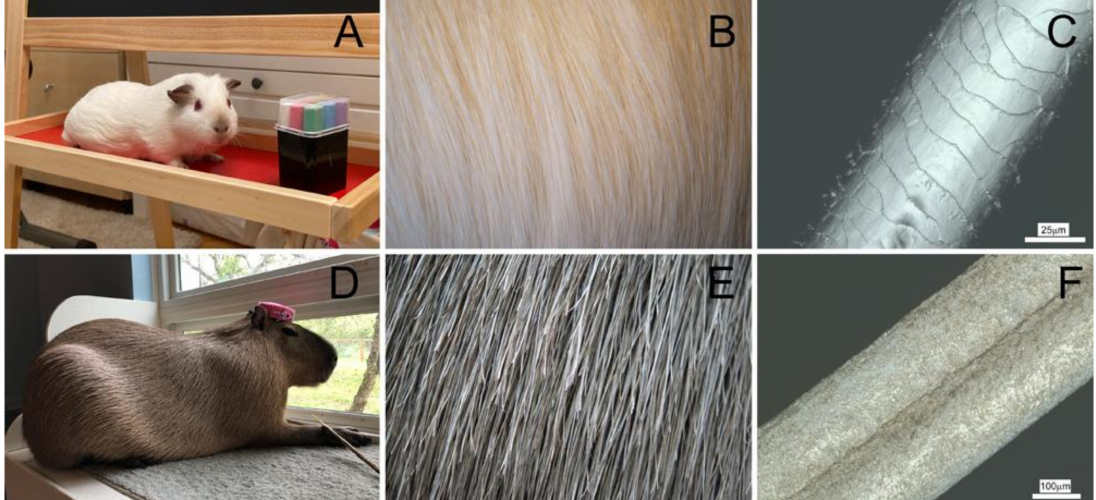
Figure 1. American breed guinea pig C. porcellus ( A ) is covered by a dense layer of insulating, thin, unwaxed hair ( B ), while the capybara H. hydrochaeris ( D ) skin is covered by long, thick, double-curved, and mechanically strong hair ( E ) aimed to protect the skin from scratches and make it water-resistant. The 3D confocal optical microscopy images of guinea pig ( C ) and capybara hair ( F ) demonstrate the fine structure and surface appearance of the hair